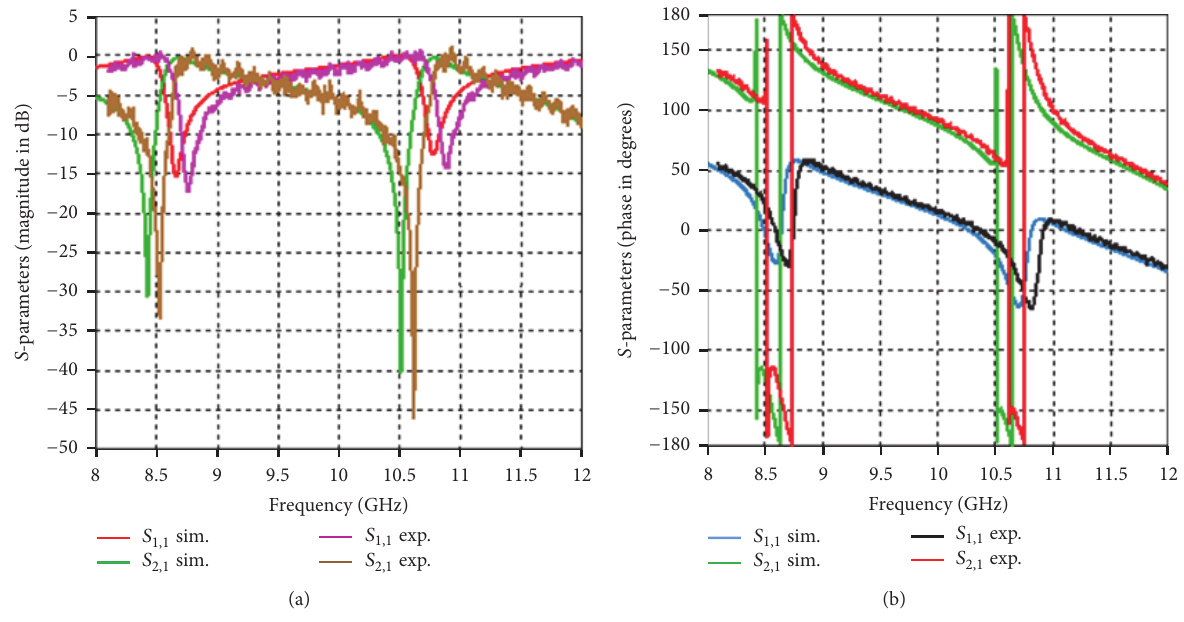
Figure 6: Simulated and measured 𝑆 -parameters: (a) the magnitude (dB) and (b) the phase